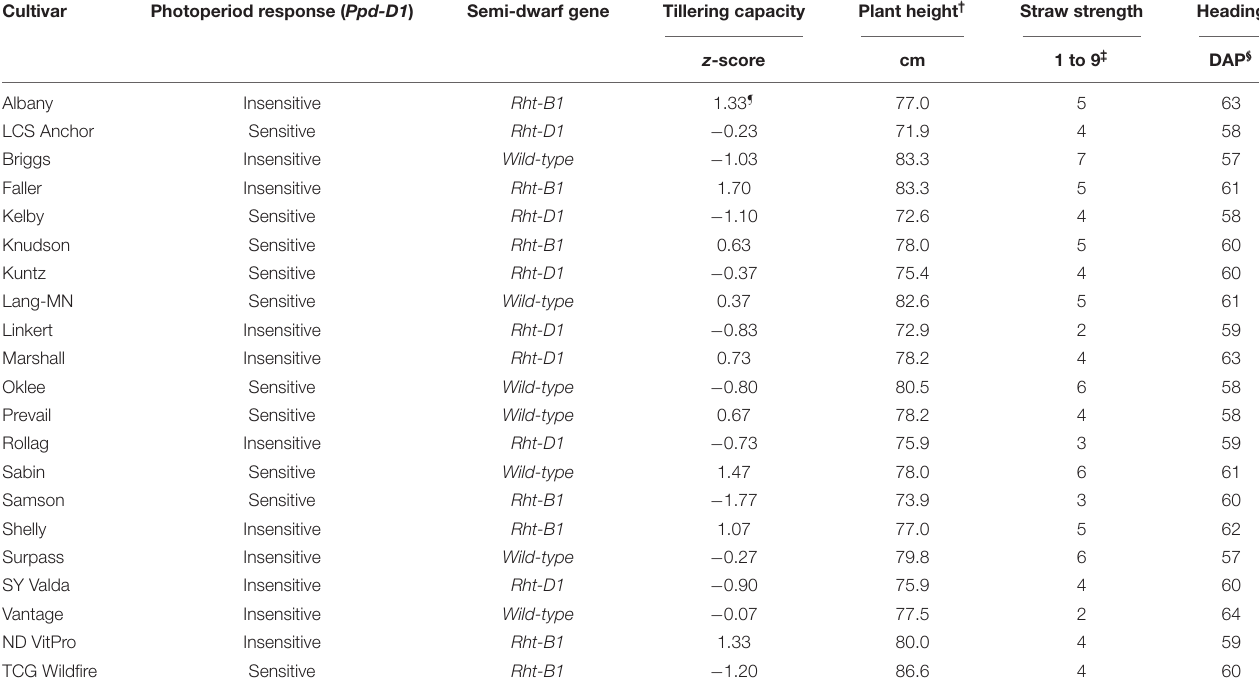
TABLE 3 | Genetic and phenotypic characteristics of HRSW cultivars. Cultivar Photoperiod response ( Ppd-D1 ) Straw strength Heading